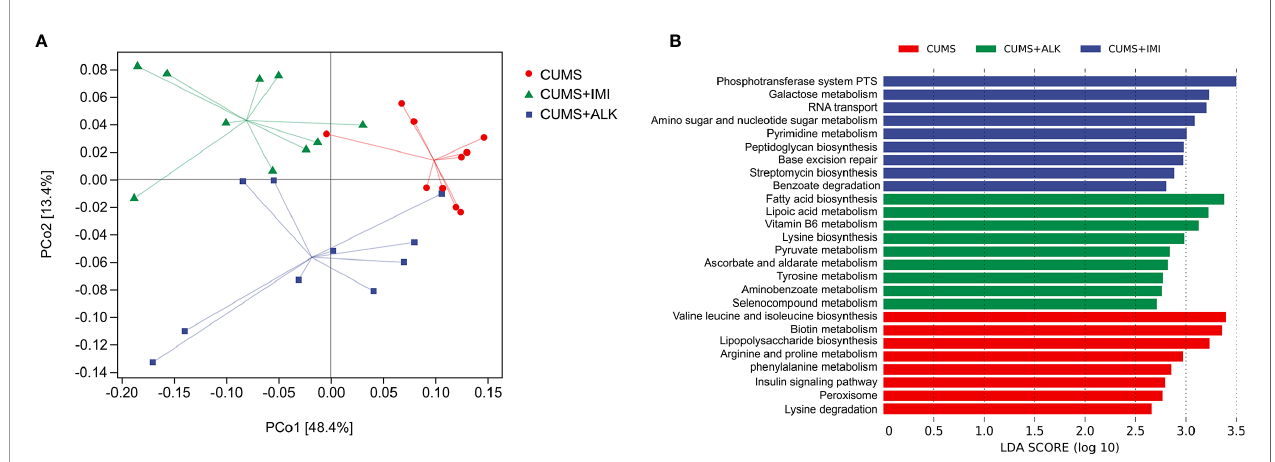
FIGURE 7 | Differences in functional units and metabolic pathways among different treatment groups. (A) Principal component analysis of functional units in different treatment groups. PCoA based on Bray-Curtis distance for gut microbiota (PCo1 vs. PCo2). Ellipses indicate 95% con fi dence intervals (CIs). (B) Differential metabolic pathways between different treatment groups, a histogram of linear discriminant analysis (LDA) scores calculated by LEfSe